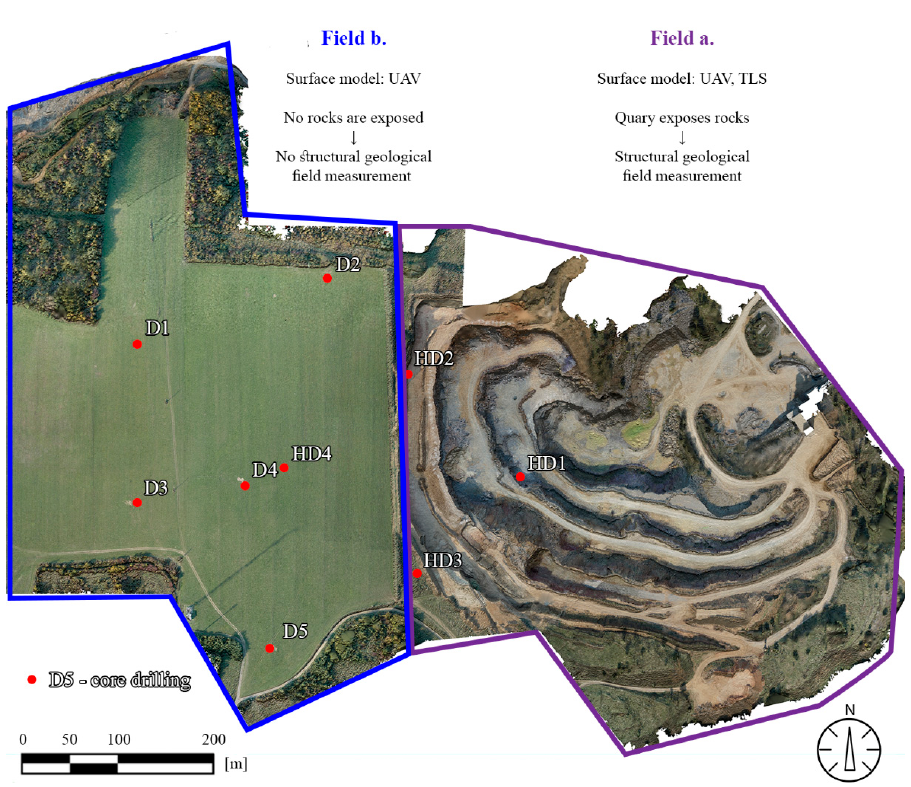
Figure 7. Surface model of the area: Field a (quarry), where both TLS and UAV were used, and due to exposed rocks it was possible to measure structural geological elements on-site, while at Field b (plateau) where only UAV was used to generate the 3D surface model it was not possible to measure structural geological elements (faults and bedding planes) with geological compass. The location of former core drillings (HD) and more recent ones (D) are also shown.